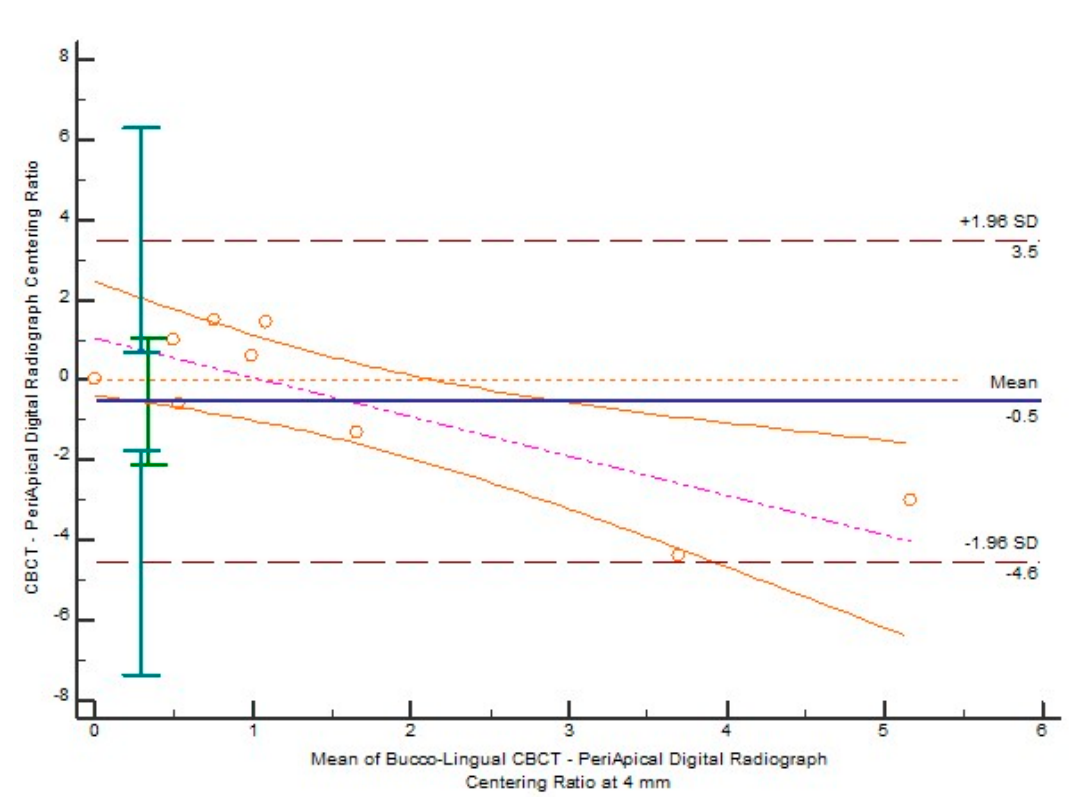
Figure 5. Bland–Altman plot for the agreement between the two methods’ measurements for the transportation in the mesio-distal direction, at a level of 3 mm.